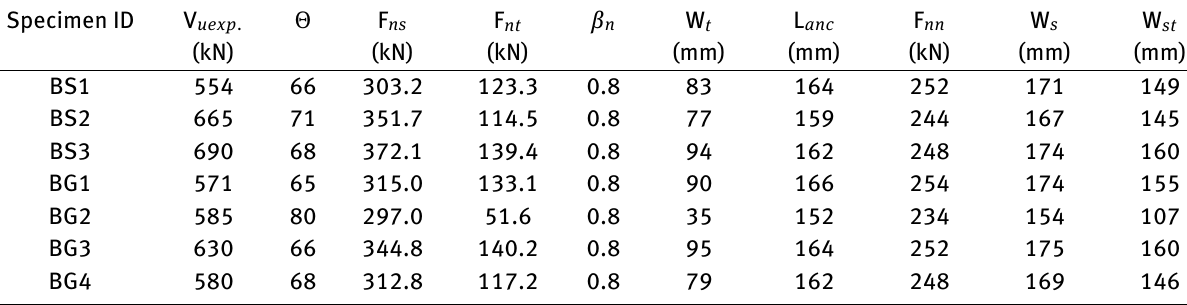
Table 9: Design of deep beams with strut and tie